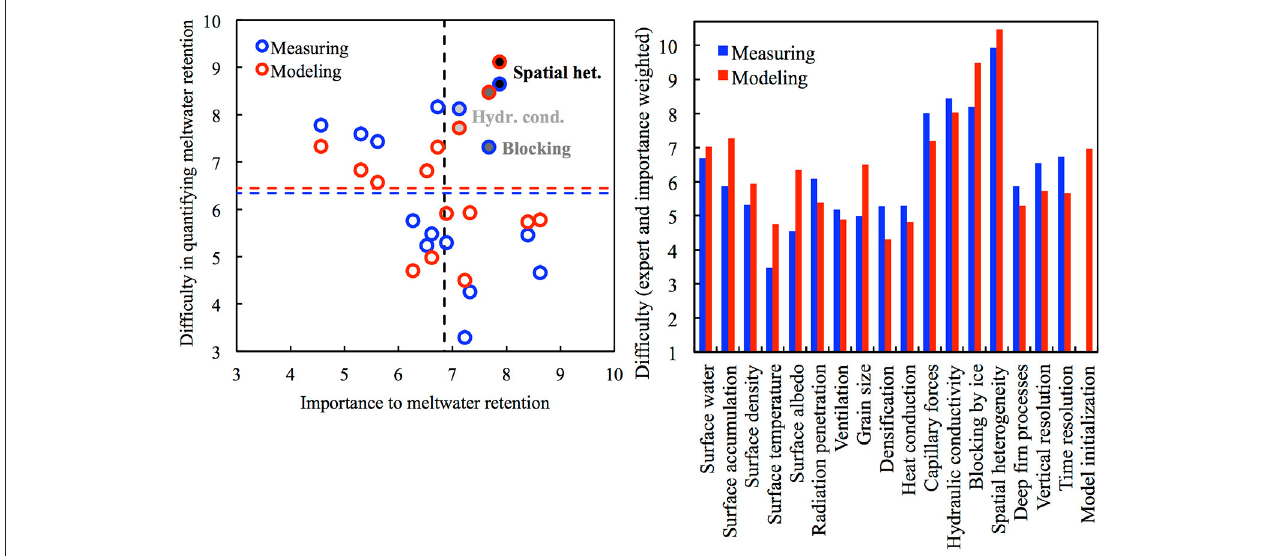
FIGURE 1 | (A) The expert-weighted difficulty in quantifying aspect in observational (blue) and modeling (red) studies of meltwater retention in snow and firn, plotted against their expert-weighted importance. Dashed lines represent average values. (B) The expert- and importance-weighted difficulty in measuring (blue) and modeling (red) studies. Ratings were provided on a scale of